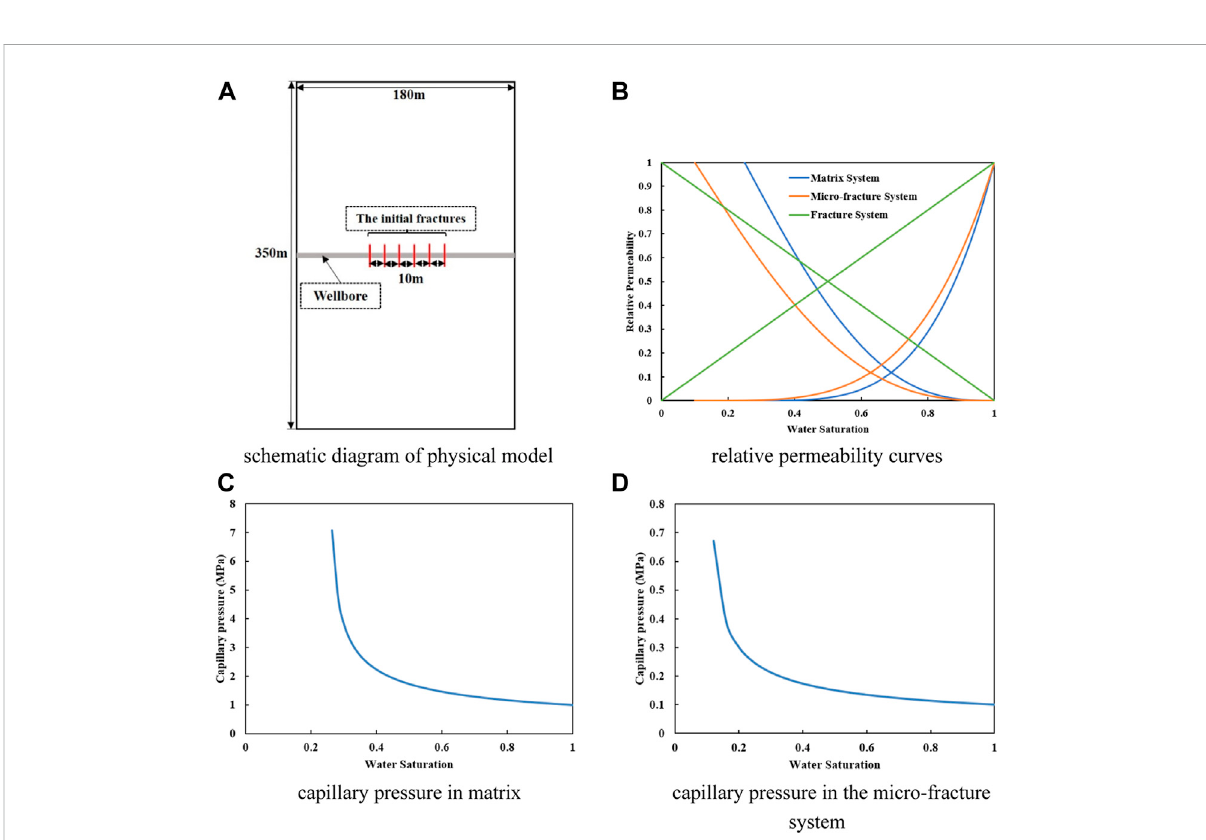
FIGURE 3 Parameters of the simulations. (A) Schematic diagram of physical model. (B) Relative permeability curves. (C) Capillary pressure in matrix. (D) Capillary pressure in the micro-fracture system.